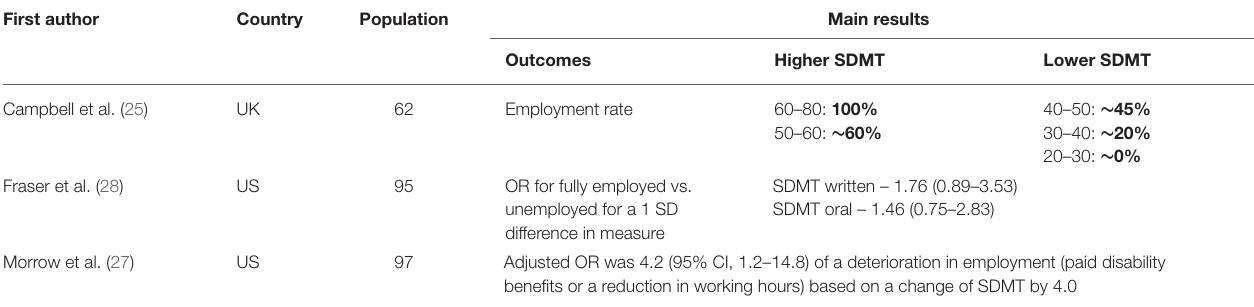
TABLE 3 | Studies that investigated employment-related outcomes in patients with MS within different levels of cognitive function. First